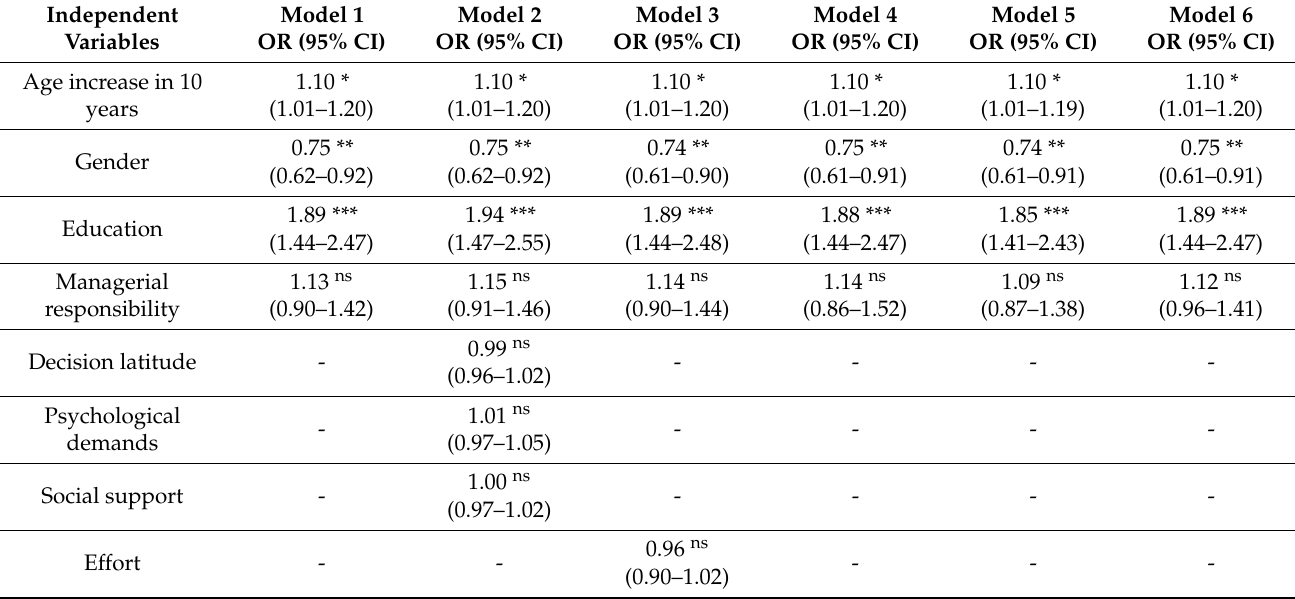
Table 3. Associations between alcohol-related presenteeism and sociodemographic variables, Job Demand Control